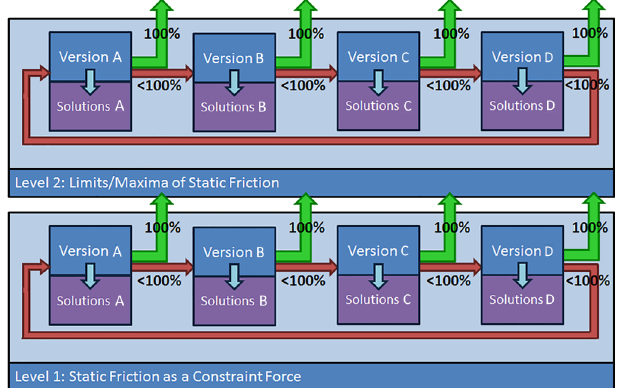
FIG. 1. Online mastery schematic shown of two example levels within week 7: Most weeks had 3 – 5 levels, with 4 versions (A – D) of problems and solutions each. Students were randomly assigned to version A, B, C, or D for their first try and had access to solutions after grading the version, then were either allowed to move on to the next level (if mastered) or call the next version of the same level (if unmastered). Calling a new version of the same level removed access to solutions and problems of the previous version.